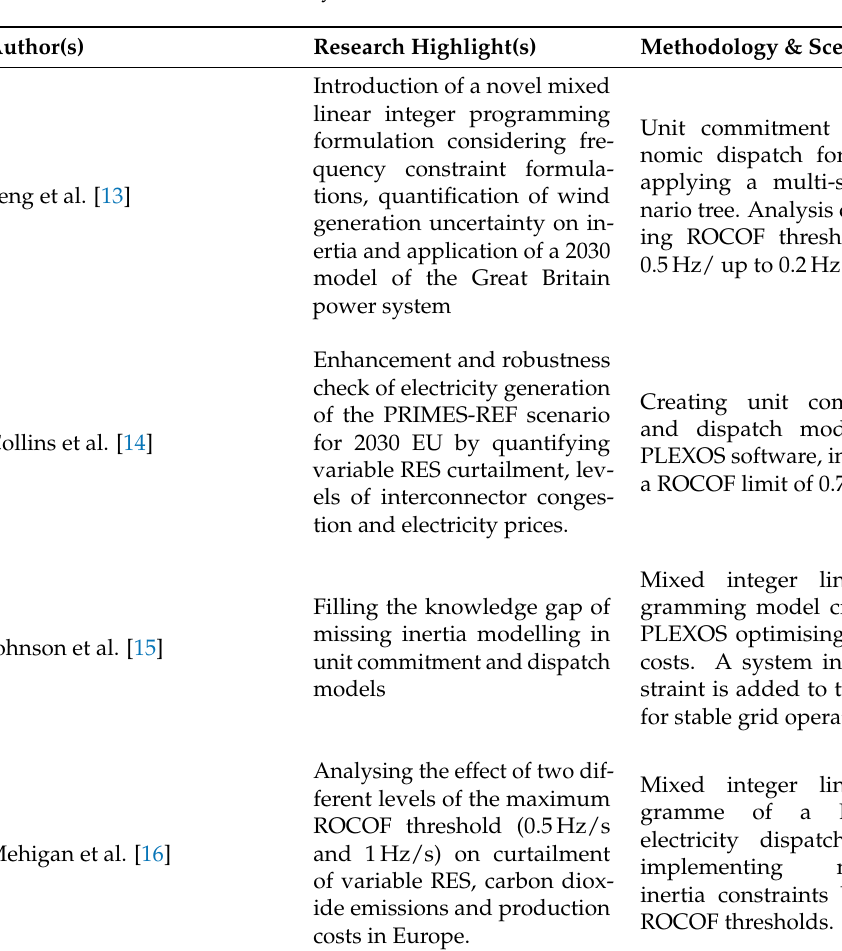
Table 1. Overview of the research highlights, the applied methodology and scenarios, as well as the key results of the reviewed